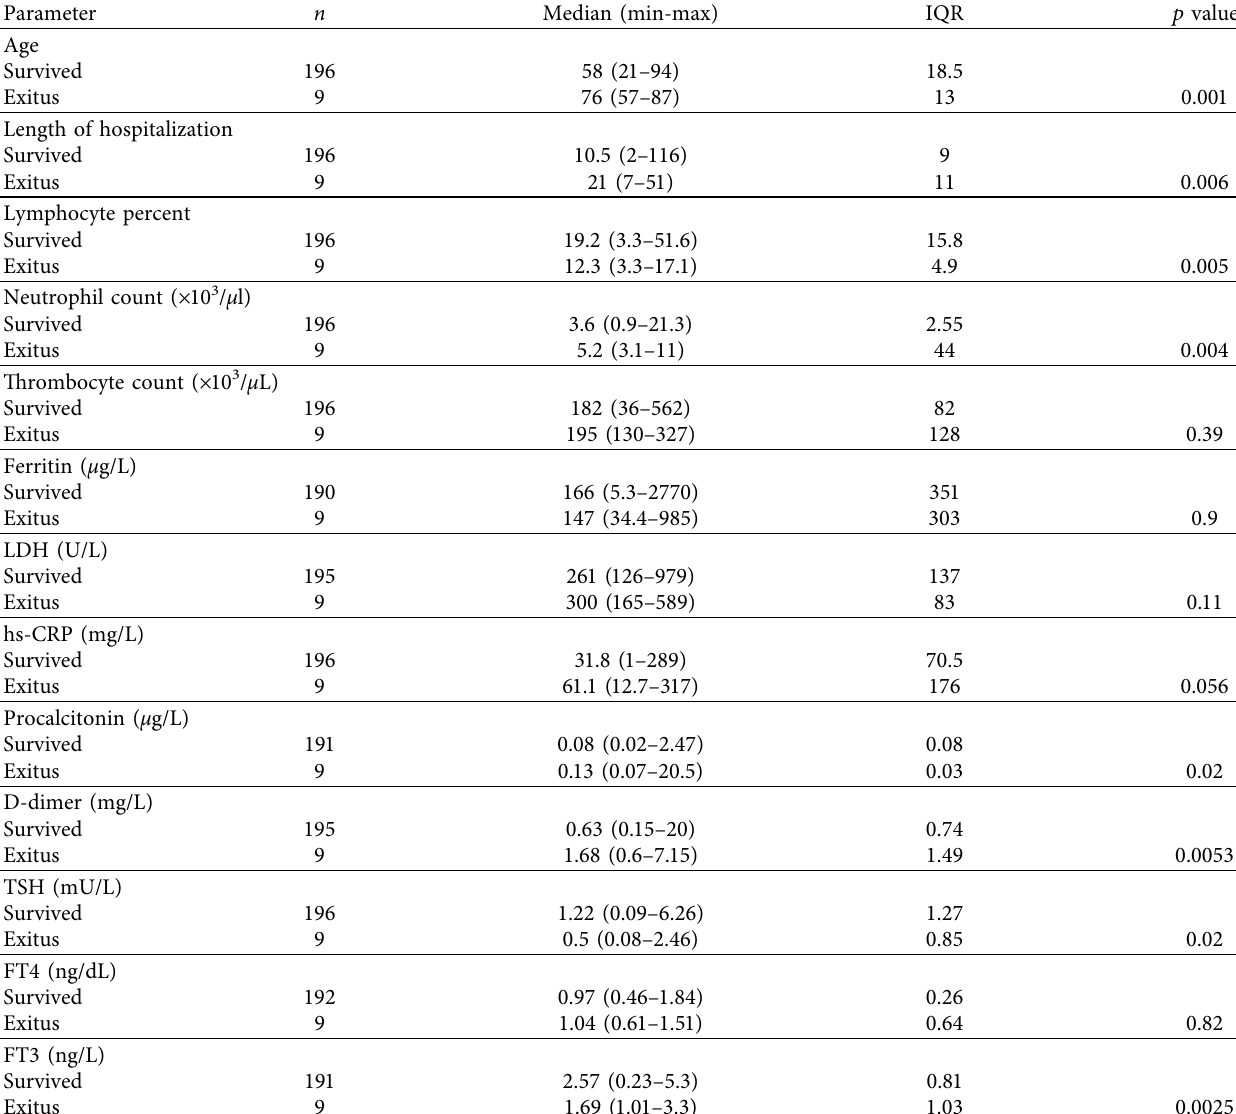
Table 5: Characteristics and laboratory parameters of patients who had died and survived from